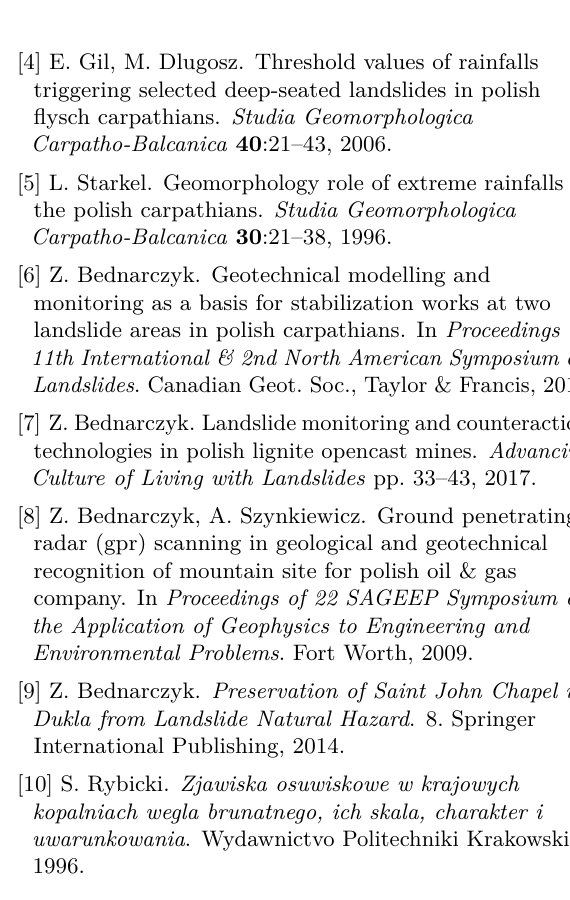
Figure 11. Results of SSR analysis 20WE, FoS=1.14, Belchatow